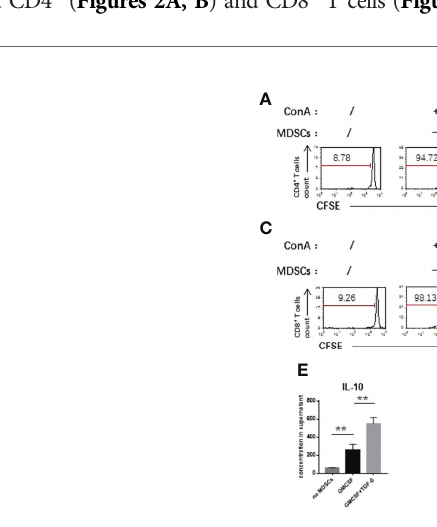
FIGURE 2 | TGF- b + GM-CSF – induced MDSCs exhibited signi fi cant immunosuppressive functions. GM-CSF and TGF- b + GM-CSF – induced MDSCs were added to the stimulated T cells proliferation system at different concentrations for 3 days. (A) Typical samples of FCM analysis for T-cell proliferation of CD4 + (T cells: MDSCs = 1:1/2). (B) Percentage of CD4 + T-cell proliferation was measured by CFSE dye dilution co-cultured with induced MDSCs at indicated ratios. (C) Typical samples of FCM analysis for T-cell proliferation of CD8 + (T cells: MDSCs = 1:1/2). (D) Percentage of CD4 + T-cell proliferation was measured by CFSE dye dilution co-cultured with induced MDSCs at indicated ratios. (E) The levels of in fl ammatory cytokines, IL-10, IL-4, TNF- a , and IFN- g in the co-culture supernatant were detected by ELISA assay (T cells: MDSCs = 1:1/2). Data have been shown as mean ± SEM (n = 3) and were analyzed by an unpaired two-tailed Student ’ s t-test and